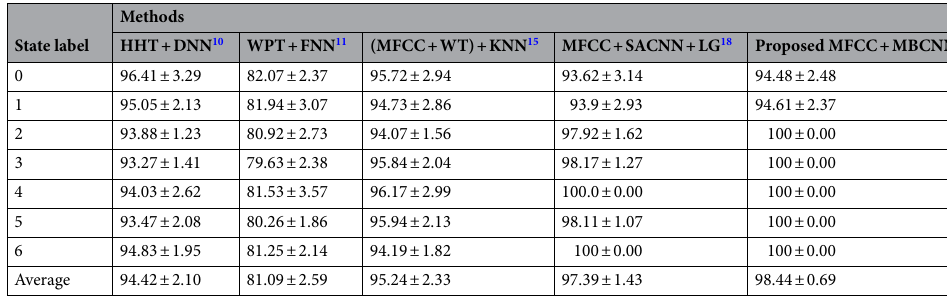
Table 3. F1-score (%) comparison with different methods on noiseless dataset.